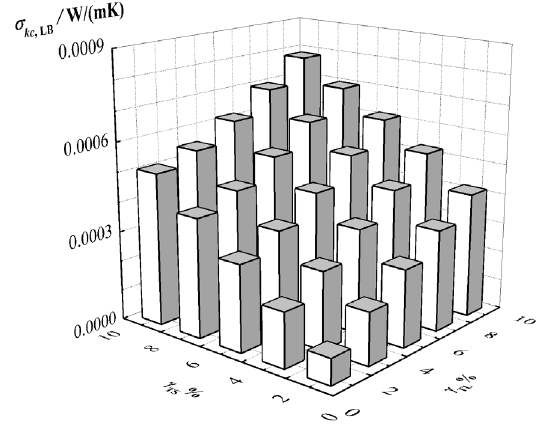
Figure 4. The σ k values with respect to various ‘measured temperature’ error γ T S % and various σ values with respect to various ‘measured temperature’ error c ,LB Figure 4. The boundary temperature error γ TH % ,LB c k γ values. ious boundary temperature error % TH